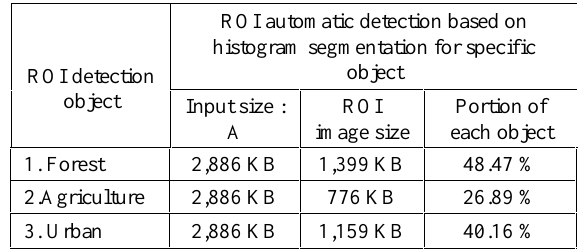
Table 5. The result of the proposed system of each process